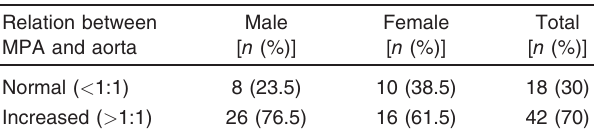
Table 3 Relation between main pulmonary artery and adjacent aorta in all cases Relation between MPA and aorta